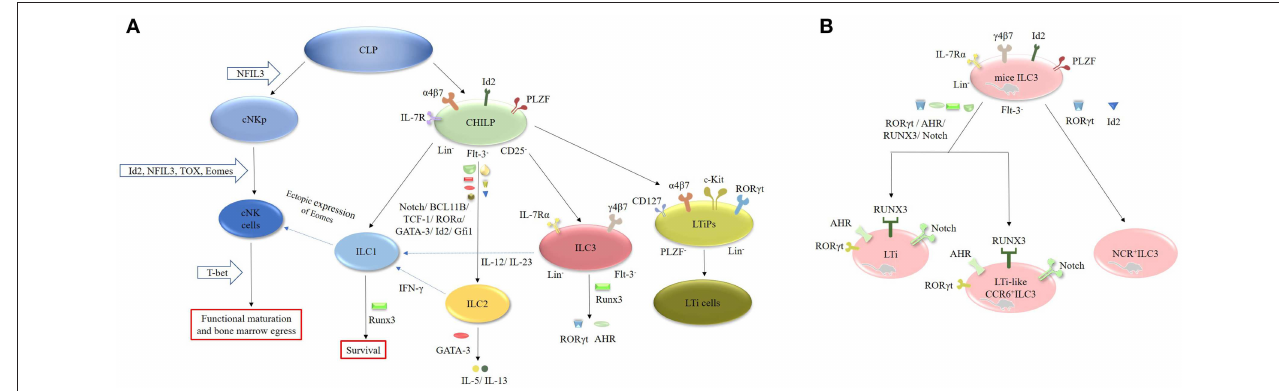
FIGURE 2 | Generation, transcription and plasticity of ILCs. (A) ILCs originate from CLPs, which subsequently differentiate into CHILPs and cNKps. cNKps can generate cNK cells. The development of cNK cells requires Id2, NFIL3, TOX, and Eomes. Its functional maturation and bone marrow egress of these cells requires T-bet. ILC1 cells arise from Id2 + PLZF + CHILP progenitor cells. The development of ILC2 cells requires Id2, GATA-3, ROR α , TCF-1, BCL11B, and Notch. ILC1 cells can be converted into NK cells after ectopic expression of Eomes. IL-12 can endow ILC2 cells with ILC1 features by secreting IFN- γ , whereas IL-12 and IL-23 can induce the transition of ILC3 cells into ILC1 cells. RUNX3 is necessary for the expression of ROR γ t and AHR in ILC3 cells. (B) The development of murine LTi and LTi-like ILC3 cells requires the expression of ROR γ t, AHR, RUNX3, and Notch, while the development of NCR + ILC3 cells need ROR γ t and